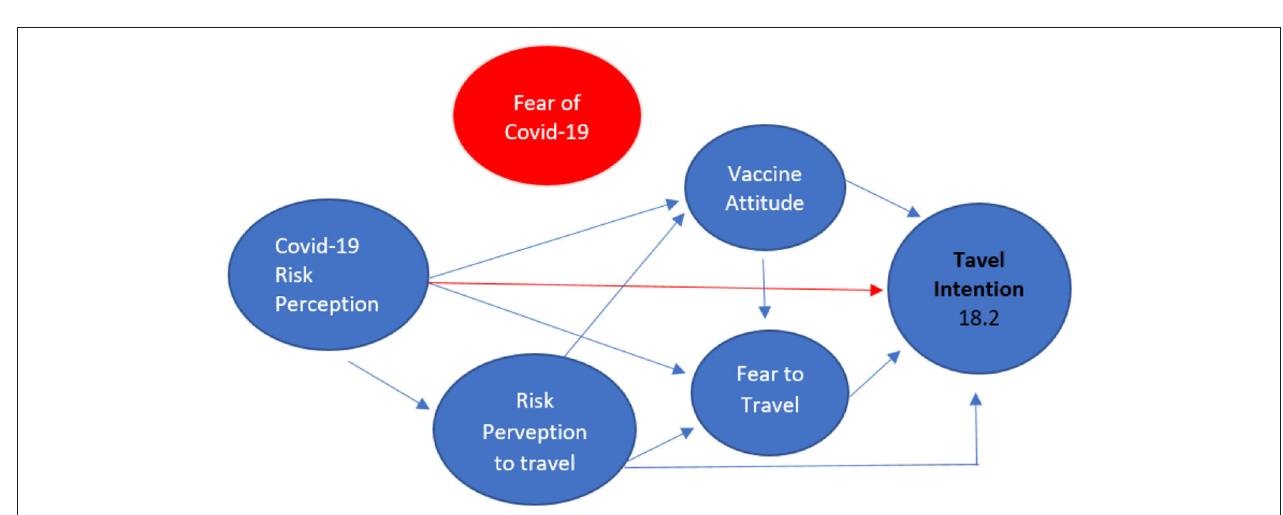
FIGURE 3 | Taiwan travel intention research